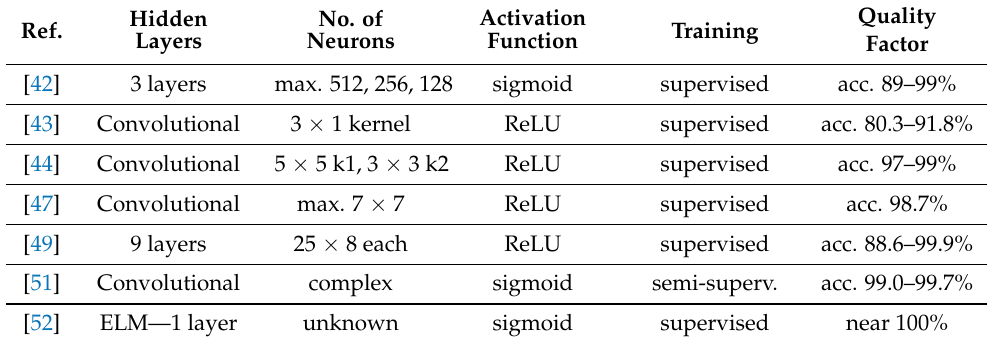
Table 4. Parameters of neural networks designed for fault